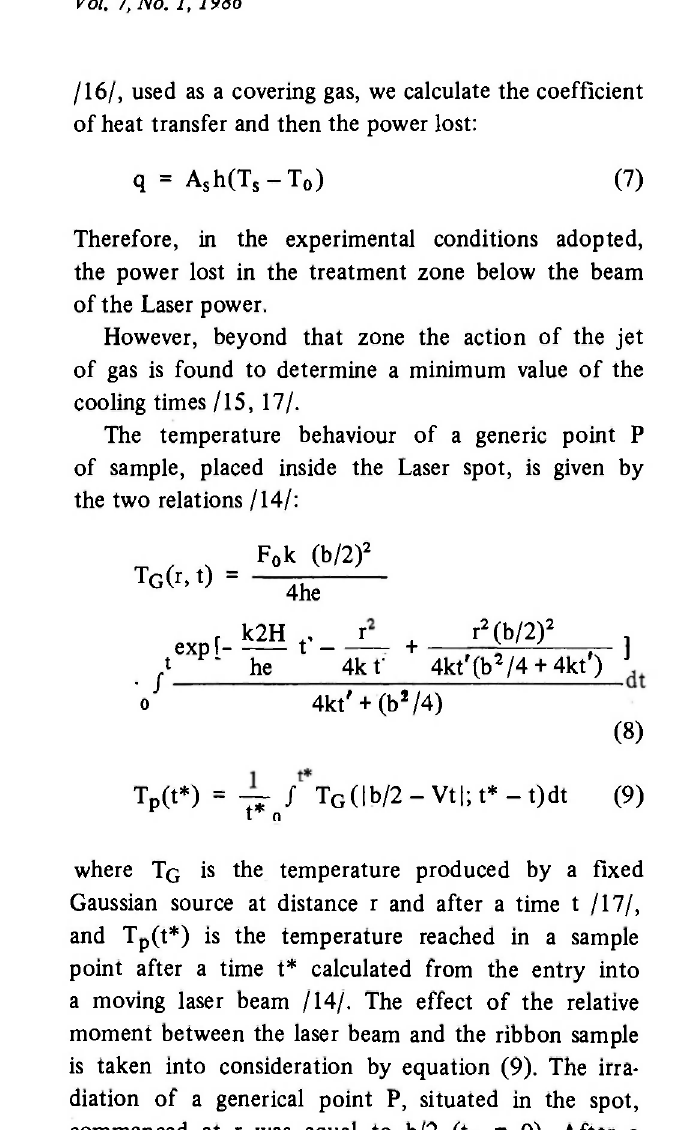
Fig. 11. Theoretical behaviour of the average